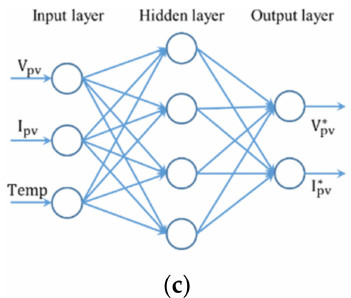
Figure 16. Neural network configuration by inputs ( a ) Electrical input; ( b ) Non-electrical input; ( c ) Combined electrical and non-electrical input.